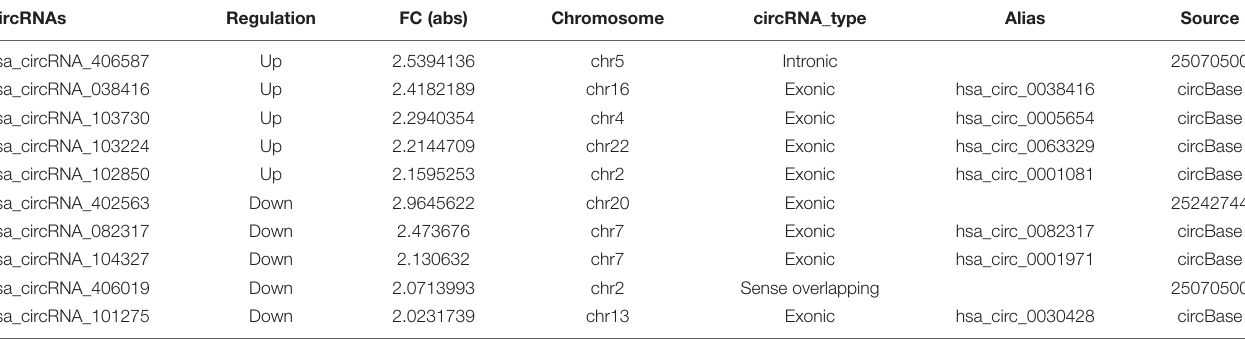
TABLE 1 | The top 5 upregulated and downregulated differently expressed circRNAs in PD group and control group. CircRNAs FC